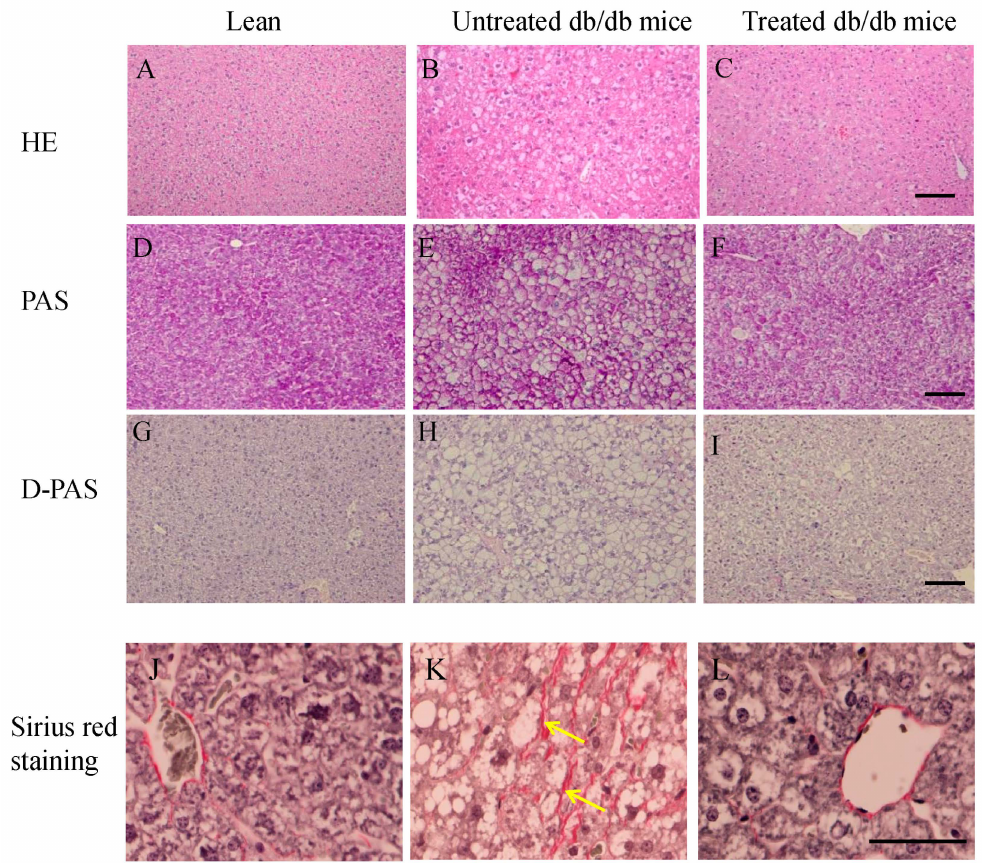
Figure 3. A – L The morphology of liver. Hematoxylin-eosin staining of livers ( A – C ); Glycogen deposits in the hepatocytes ( D – F ) by PAS reaction, after diastase digestion (D-PAS) ( G – I ); Livers of lean, untreated and treated db/db mice were stained by Sirius red staining. There was more fibrosis (arrows) in the untreated db/db mice ( K ) than lean ( J ) and treated db/db mice ( L ). Scale bar = 25 µ